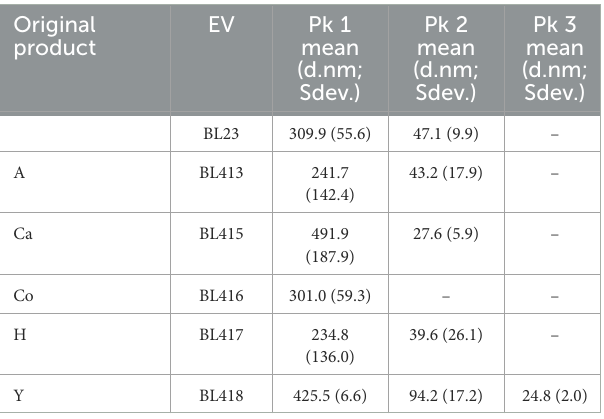
TABLE 1 The average particle size of EVs obtained for the lactobacilli isolated from different commercial products found in 100K pellets and determined by